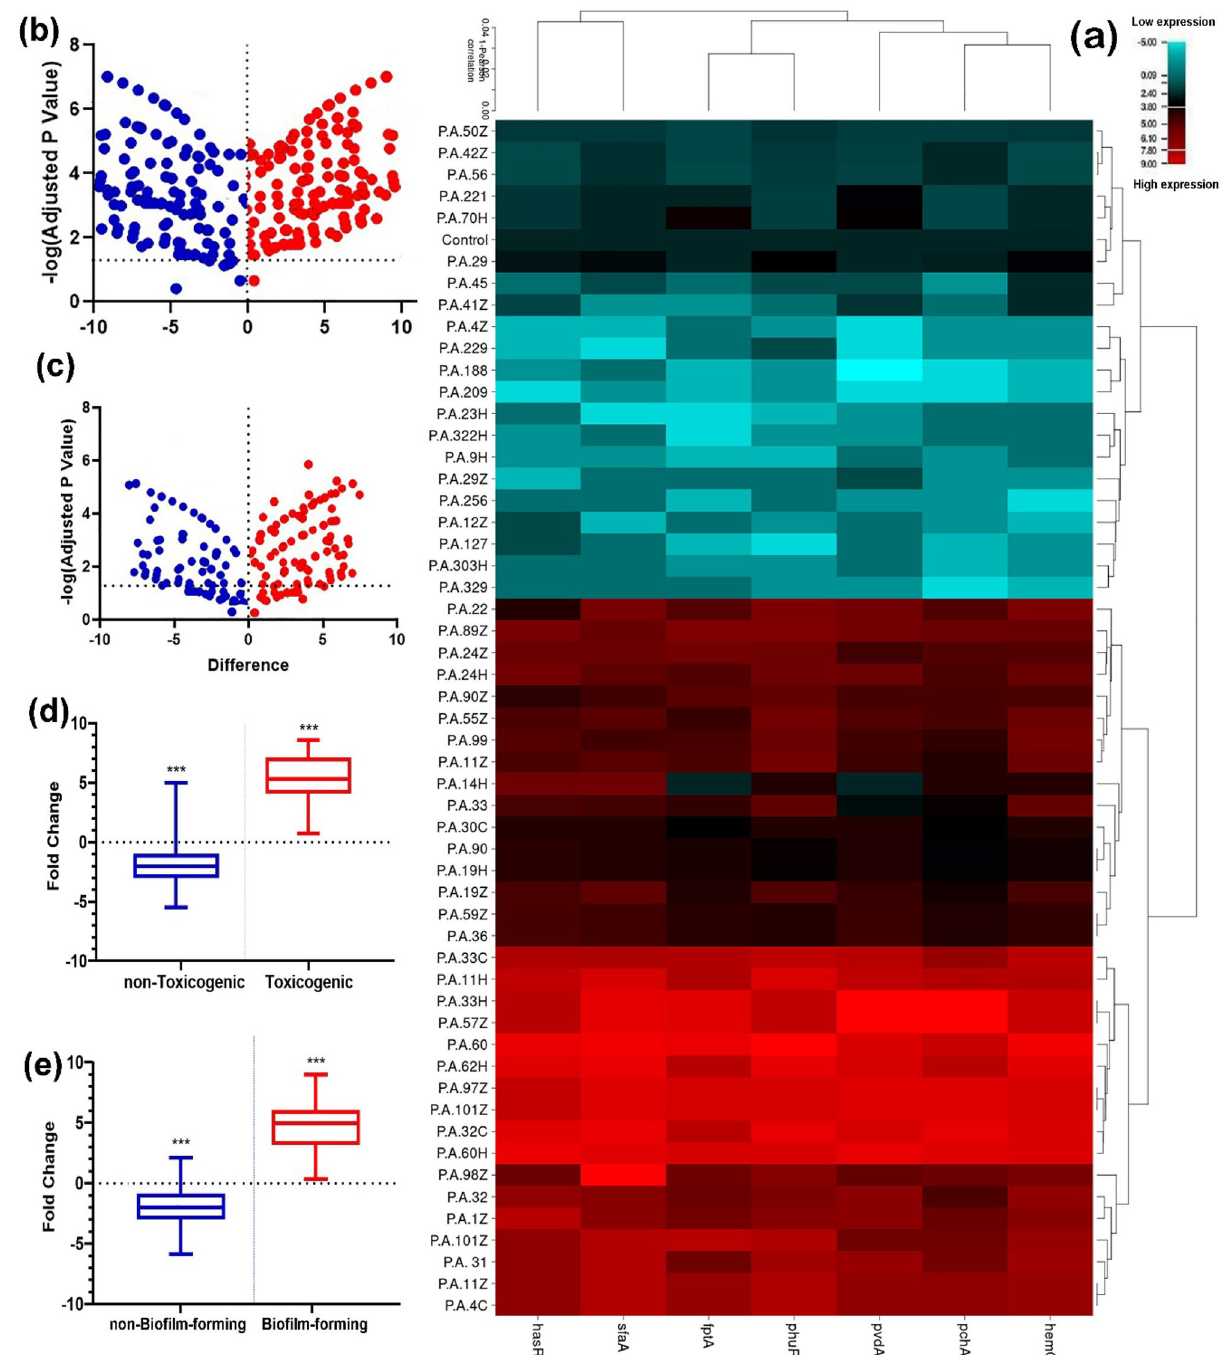
Figure 2. Differential expression of iron-uptake and siderophore system in wound infection isolates of P. aeruginosa. Isolates with the potential to form biofilm, non-biofilm-forming, versus toxigenic and non-toxigenic strains. ( a ) Heatmap iron-uptake and siderophore system expression patterns in all 55 P. aeruginosa . Blue represents up-regulation and red down-regulation relative to control. ( b ) The volcano plots of iron-uptake and siderophore system genes expressions between toxigenic and non-toxigenic isolates. Expressions analysis based on p-value and log 2 (fold-change) at an α level of 0.05 and. ( c ) The volcano plots of iron-uptake and siderophore system genes expressions between biofilm and non-biofilm forming isolates, discriminated based on p-value and log 2 (fold-change) at an α level of 0.05. ( d ) Expression levels of iron-uptake and siderophore system genes between toxigenic a non-toxigenic isolate. Expressions analysis based on p-value and log 2 (fold-change) at an α level of 0.05. ( e ): Expression levels of iron-uptake and siderophore system genes between biofilm non-biofilm forming isolates, discriminated based on p-value and log 2 (fold-change) at an α level of 0.05. Error bars standard errors: 0.05. Student’s t-test and Tow-Way ANOVA test were performed for testing differences between groups. *p < 0.05, **p < 0.001, ***p <